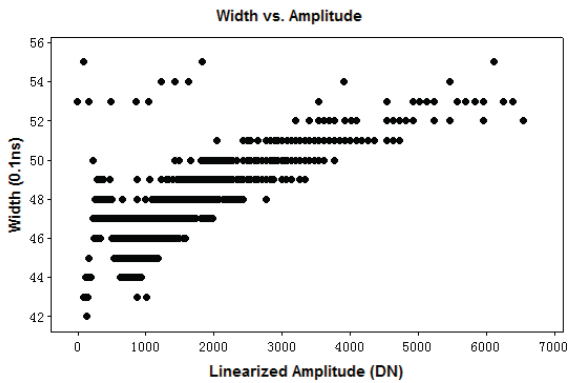
Figure 5. Scatter plot of width versus linearized amplitude for rooftop surfaces with extremely high amplitudes. The samples are taken from the area inside the red box in Figure